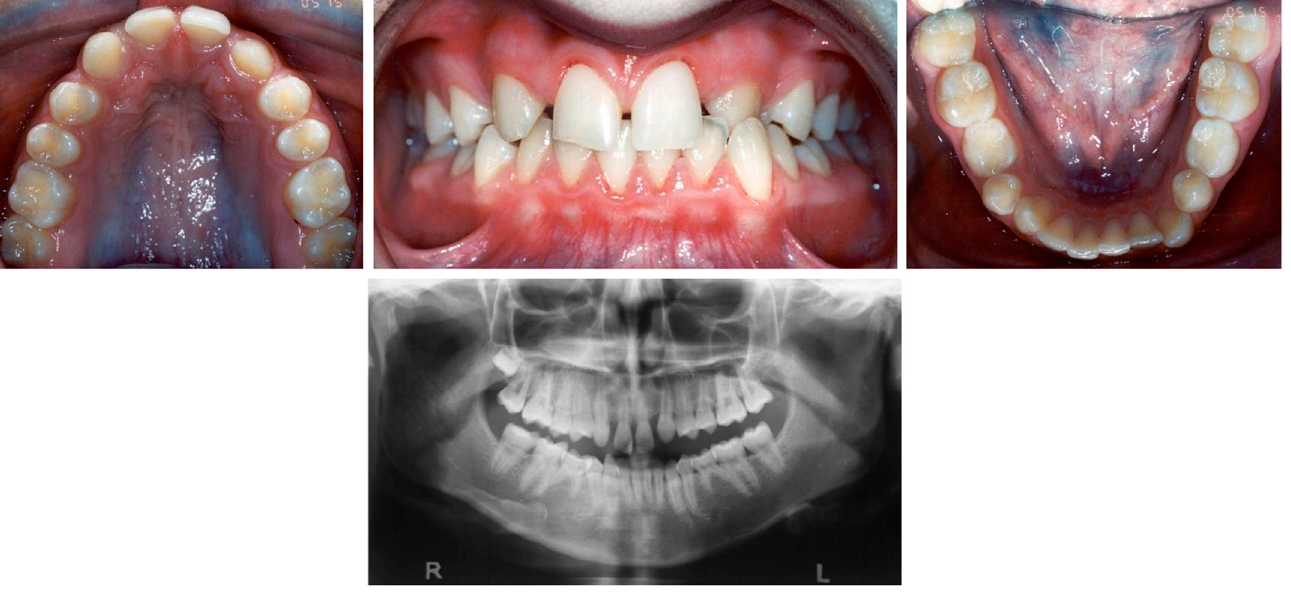
Figure 5. Post-treatment photographs following space closure of the missing teeth in both arches. 5. Limitations of the Study The study sample was limited to orthodontic patients treated at a University Ortho- dontic Clinic. Thus, the prevalence rate discovered here does not represent the prevalence and patterns of tooth agenesis among the general population, which justify an additional investigation in the future. 6. Conclusions An overall prevalence of 11% for missing permanent teeth in orthodontically treated individuals was found with a 3:2 female:male ratio, and a higher prevalence in the maxilla than in the mandible.